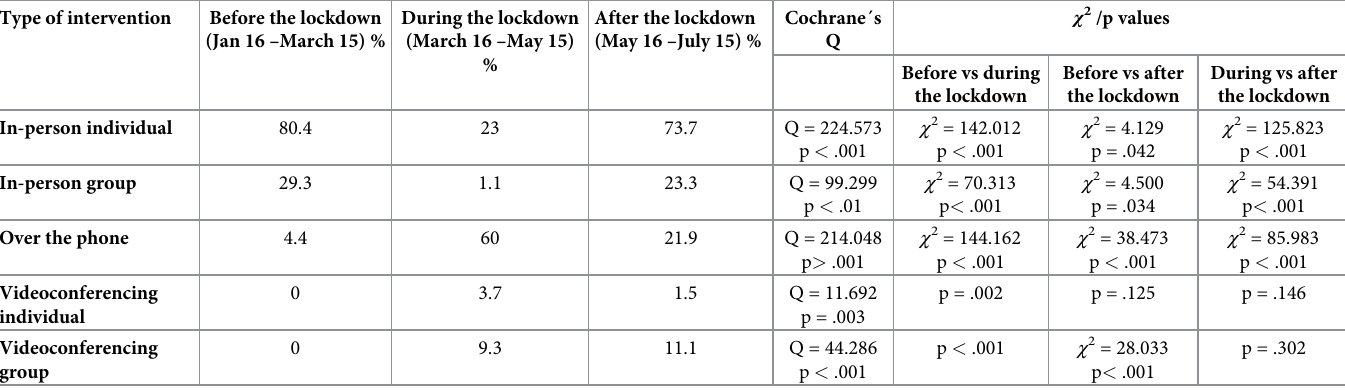
Table 2. Comparison of interventions received before the pandemic, during the lockdown, and after the first wave. Type of